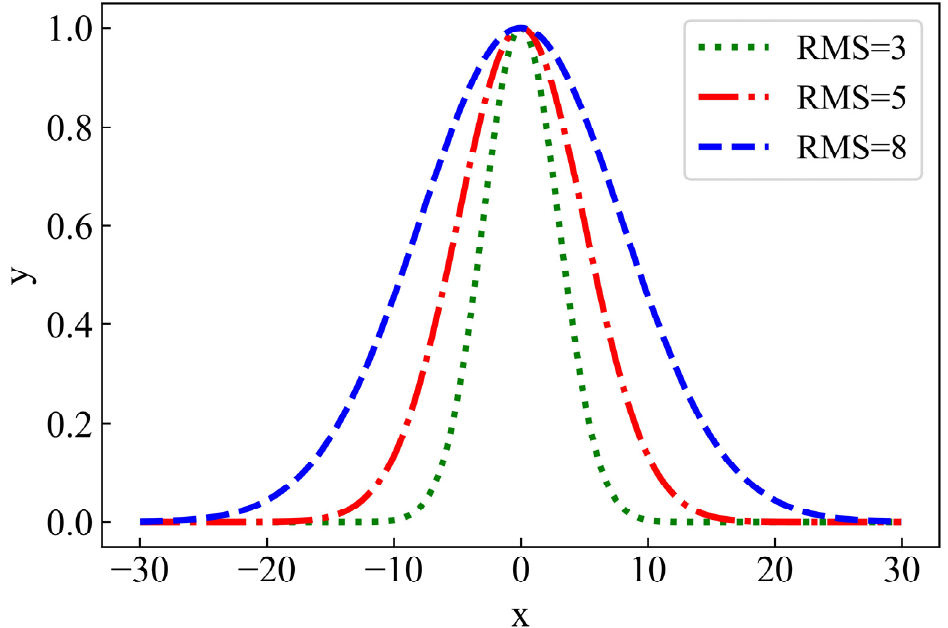
Figure 3. Gaussian function curves with different